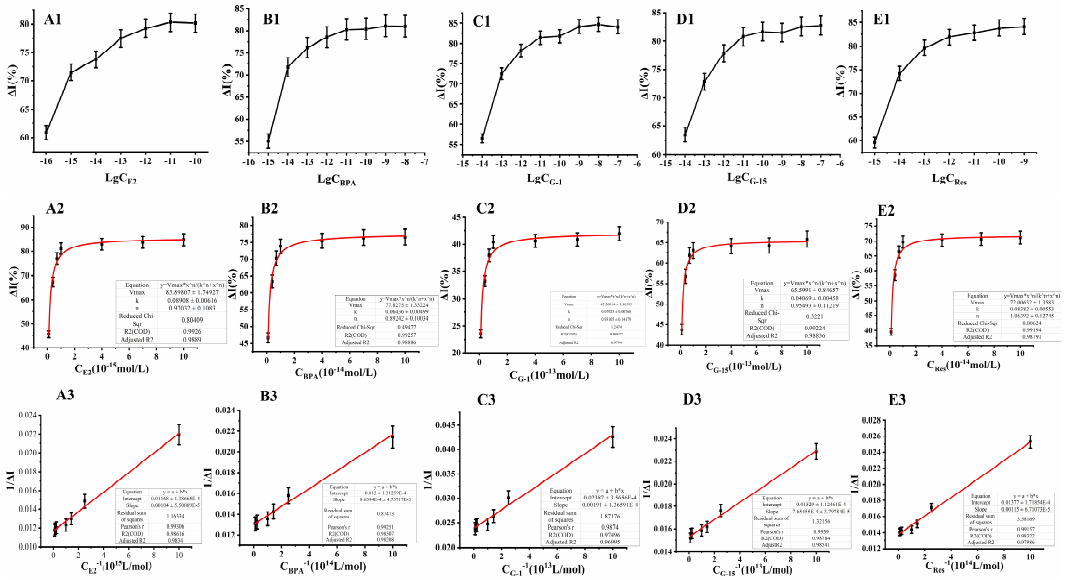
Figure 5. ( A1 ) Current response values of E2 in the detection range (C = 10 − 16 mol/L~10 − 10 mol/L); ( A2 ) The curve of interaction between E2 (10 − 16 mol/L~10 − 14 mol/L) and the receptor; ( A3 ) Plotting with double reciprocal: E2 in the concentration range of 10 − 16 mol/L~10 − 14 mol/L; ( B1 ) Current response values of BPA in the detection range (C = 10 − 15 mol/L~10 − 8 mol/L); ( B2 ) The curve of interaction between BPA and the receptor; ( B3 ) Plotting with double reciprocal of BPA; ( C1 ) Current response values of G − 1 in the detection range (C = 10 − 14 mol/L~10 − 7 mol/L); ( C2 ) The curve of interaction between G − 1 and the receptor; ( C3 ) Plotting with double reciprocal of G − 1; ( D1 ) Current response values of G − 15 in the detection range (C = 10 − 14 mol/L~10 − 7 mol/L); ( D2 ) The curve of interaction between G − 15 and the receptor; ( D3 ) Plotting with double reciprocal of G − 15; ( E1 ) Current response values of Res in the detection range (C = 10 − 15 mol/L~10 − 9 mol/L); ( E2 ) The curve of interaction between Res and the receptor; ( E3 ) Plotting with double reciprocal of Res.